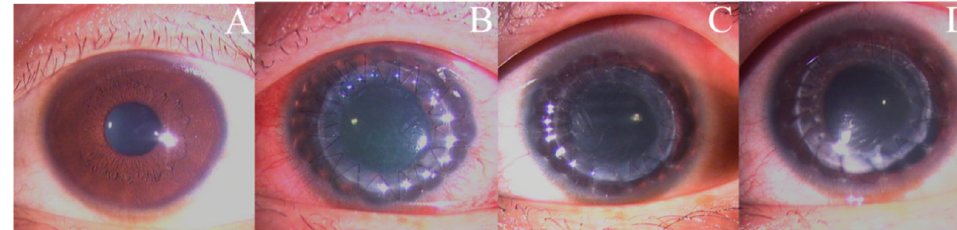
Figure 1. Anterior segment photographs of three UZS patients during the 3-month follow-up period. A 21-year-old male with keratoconus in his left eye: ( A ) preoperatively; ( B ) three days postoperatively; ( C ) one month postoperatively; ( D ) three months